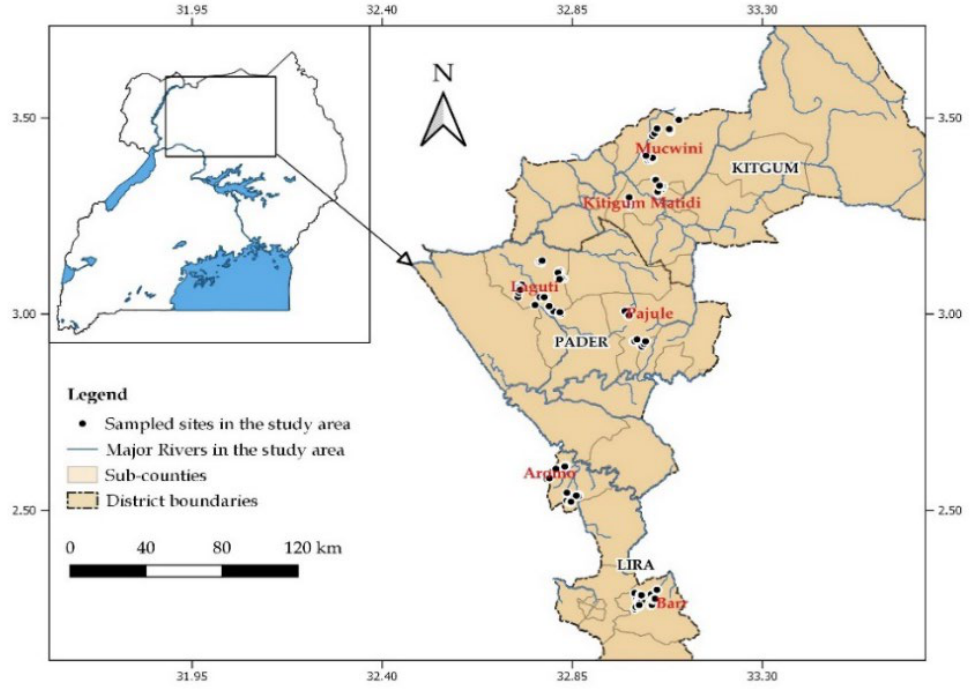
Figure 1. The study districts of Lira, Pader, and Kitgum districts in northern Uganda, black dots represent sampled households.